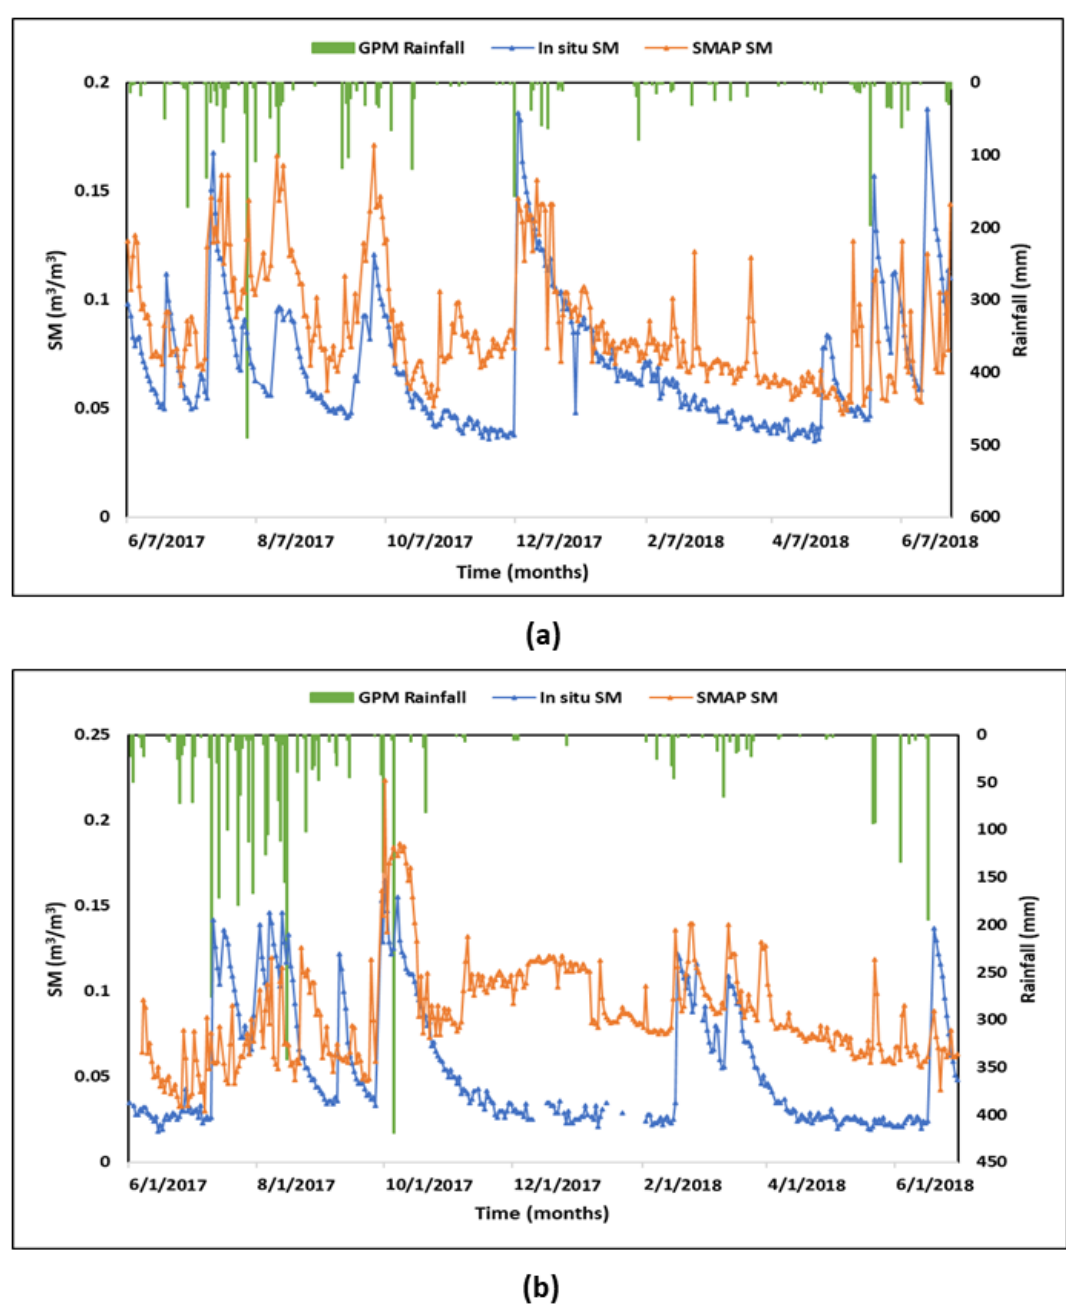
Figure 4. Temporal series plot between the SMAP SM, in situ SM and GPM rainfall for ( a ) Panther Junction, Texas and ( b ) Socorro, Minnesota, North America.